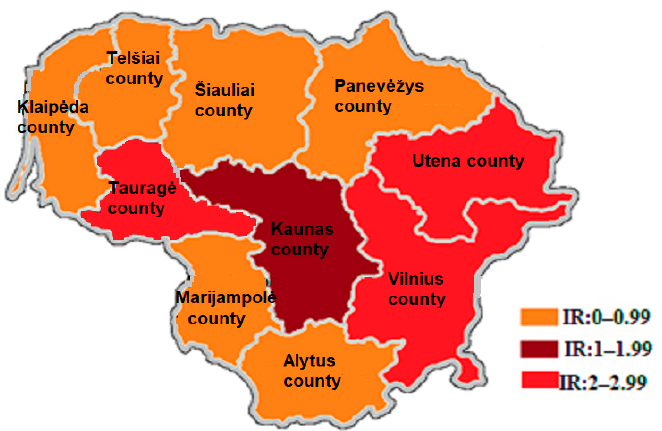
Figure 4. Average incidence rates of acute hepatitis C virus by the county where cases were reported, Lithuania, 2005–2018.